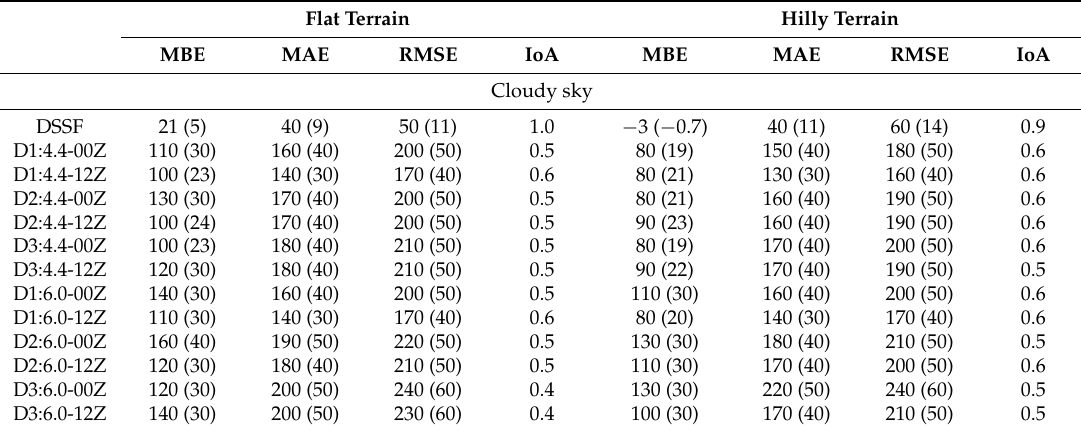
Table 2. Cont . Flat Terrain Hilly Terrain